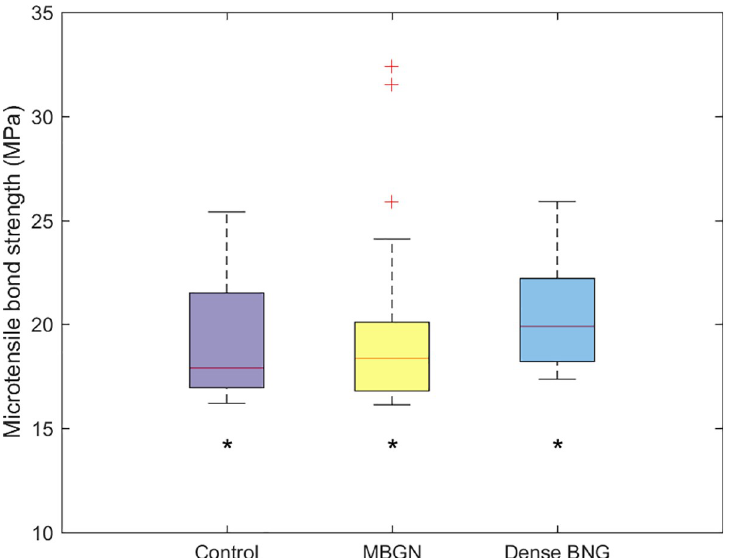
Fig 13. Microtensile bond strength of control, dense BGN, MBGN. Superscript letter ’ � ’ indicates no significant difference (p > 0.05).